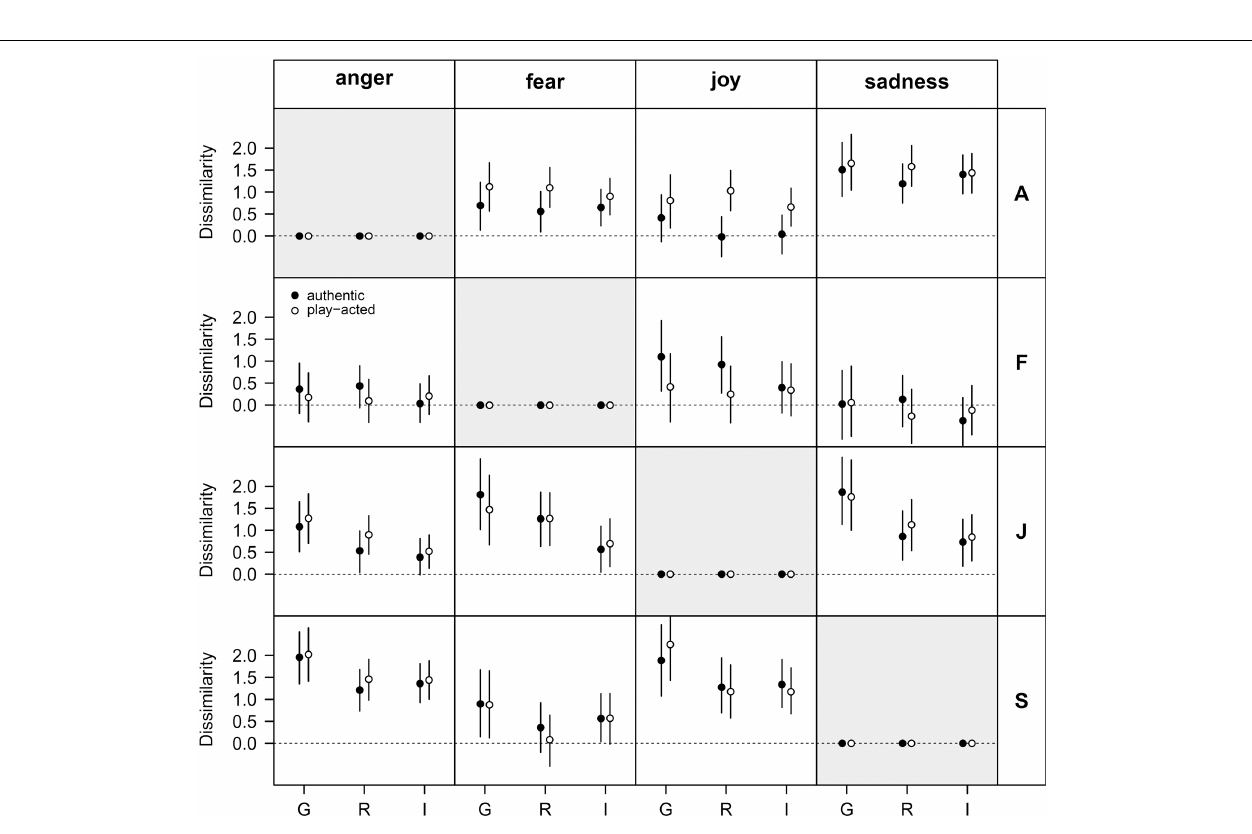
sadness), respectively. Filled and open symbols refer to authentic and play-acted conditions, respectively. Data are given as means and 95% uncertainty interval.The dissimilarity describes how well each stimulus (depicted by rows) is discriminated from each other stimulus (depicted by response